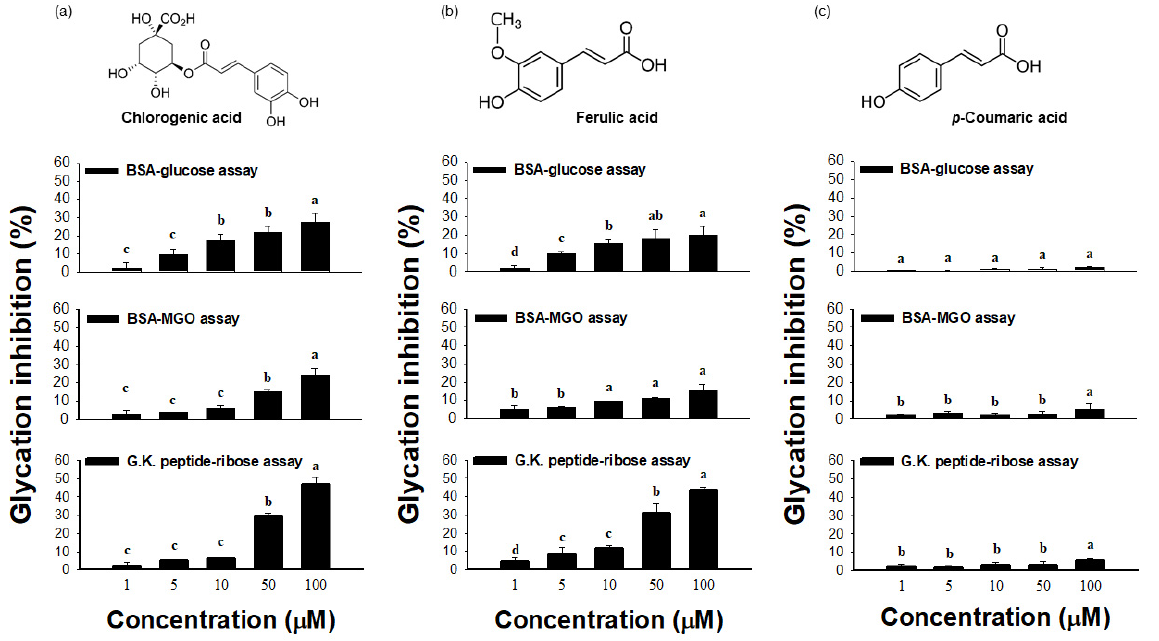
Figure 7. Chemical structures and the effects of chlorogenic acid ( a ), ferulic acid ( b ), and p -coumaric acid ( c ) identified in ATE-BuOH fractions on protein glycation and crosslinking. Dose responses of glycation inhibition (%) on individual stages of protein glycation were determined by model systems of the BSA-glucose assay (upper panel), the BSA-MGO assay (middle panel), and the G.K.-ribose assay (bottom panel). Data are the means ± SD for n = 6. Groups with different letters (a–d) are significantly different from each other in individual assays ( p < 0.05).